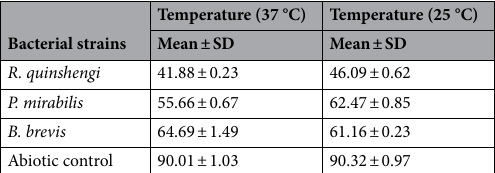
Table 2. Levels of unmetabolized pyrene (ppm) in bacterial cultures at day 18 with varying temperatures. SD standard deviation.